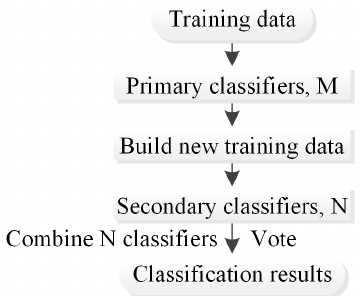
Figure 7. Flowchart of the stacking method .